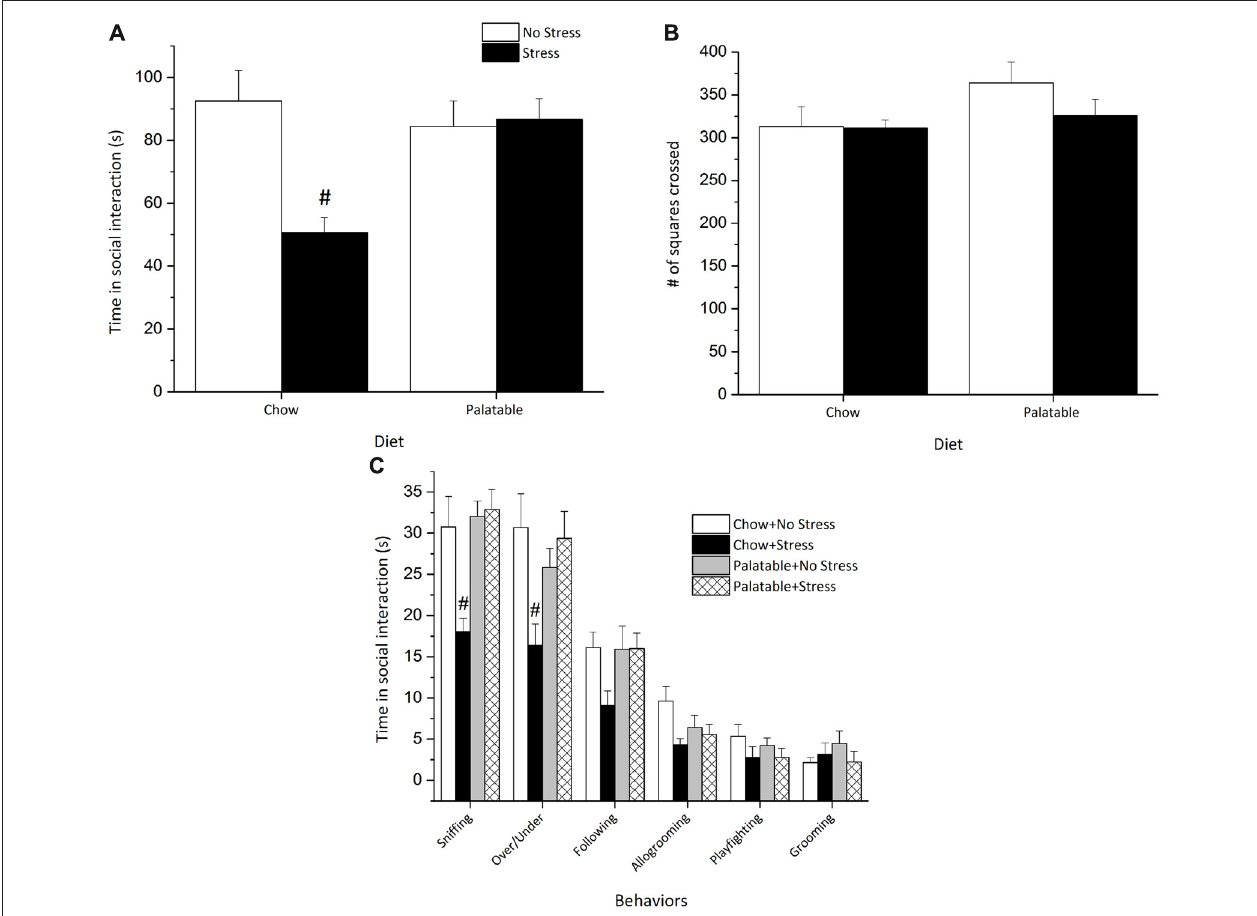
FIGURE 5 | Access to a palatable diet prevents the decrease in social interaction in adulthood elicited by juvenile stressor exposure. (A) Adult rats exposed to juvenile stress exhibited an overall reduction in total social interaction and this effect was reversed in palatable diet fed rats. (B) Locomotor activity (# of squares crossed) was comparable across groups. (C) Juvenile stressor exposure decreased sniffing and over/under behaviors. # Significantly different from other conditions ( p <